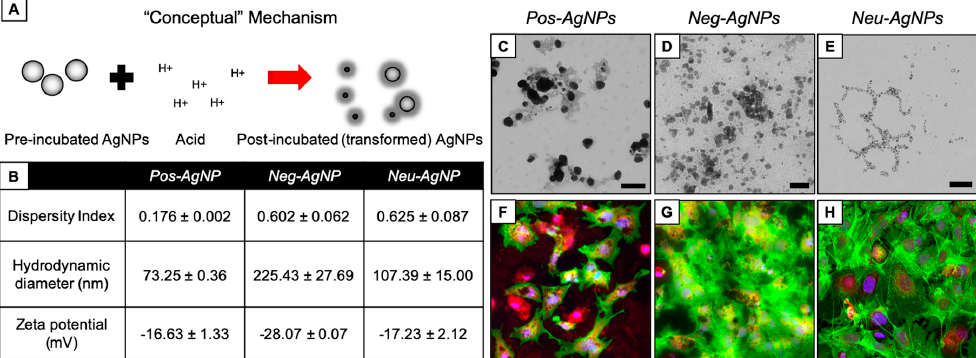
Figure 6. AgNP transformation after incubation in acid. ( A ) Conceptual model of transformation mechanisms. ( B ) Dispersity index (unitless), hydrodynamic diameter (nm), and zeta potential (mV)